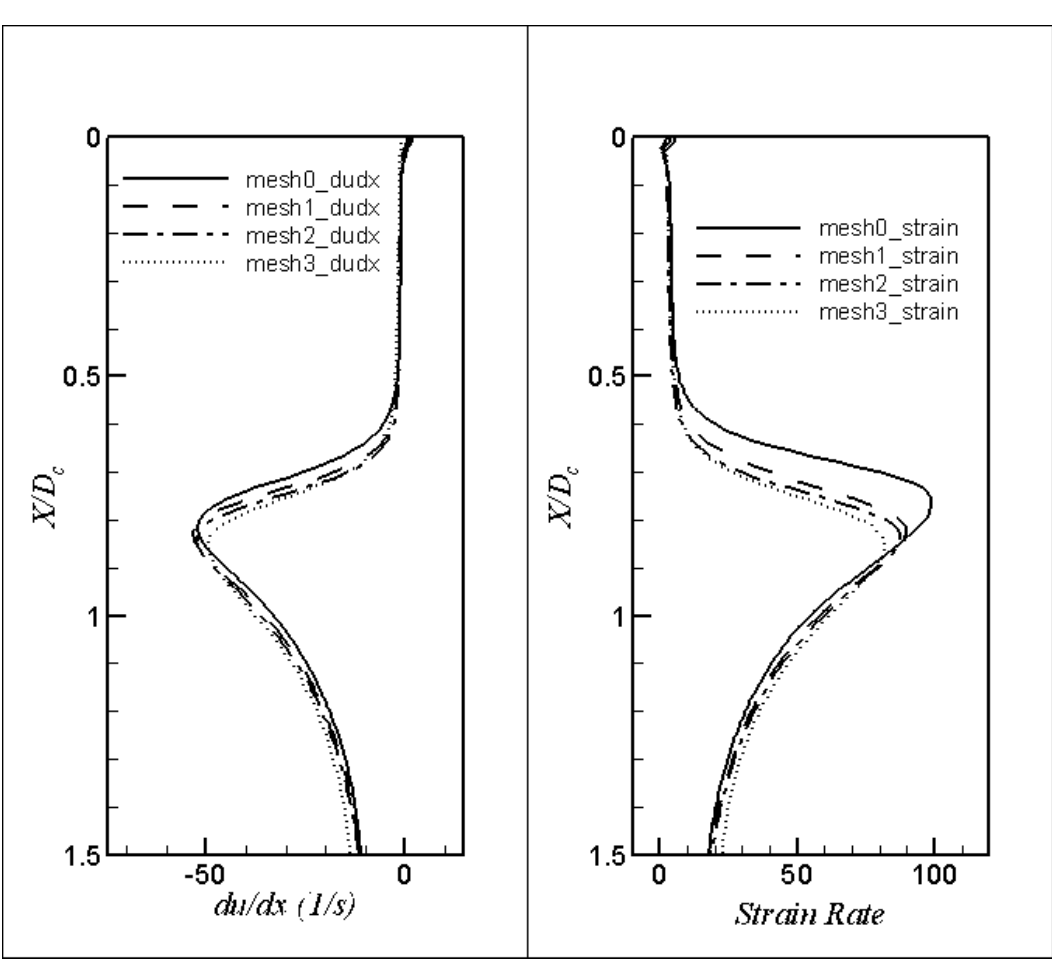
Figure 5: Left: center line axial velocity gradient ( dXdU / ), right: center line strain rate for three different meshes V =12 [ q